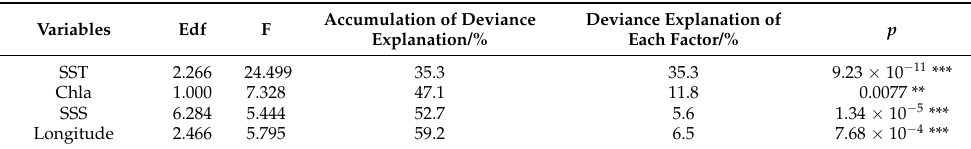
Table 5. The results of the optimal GAMs.